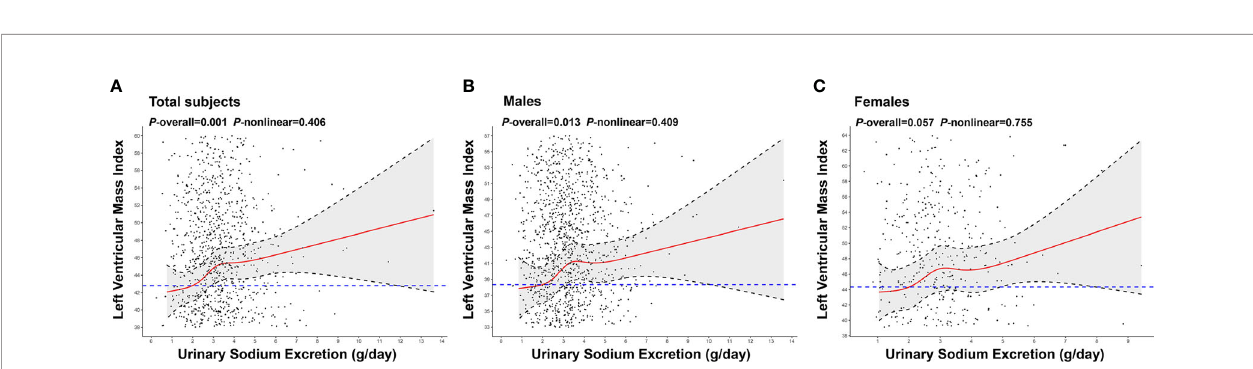
FIGURE 2 | Association of urinary sodium excretion with LVMI. The restricted cubic spline (RCS) regression was used to analyze the relationship of urinary sodium excretion(g/day) with left ventricular mass index (LVMI) after adjusting for age, gender, smoking, alcohol consumption, hypertension, use of RAS blocking agents, use of diuretics, history of hyperlipidemia, use of statin, HbA1c and use of antidiabetic medication in total individuals (A) , males (B) , females (C) . Urinary sodium excretion was coded using an RCS function with fi ve knots located at the 5th, 25th, 50th, 75th, 95th percentiles of the distribution of urinary sodium excretion. Y-axis represents the predicted value of LVMI. Individuals with 2g/day of urinary sodium excretion was the reference standard, indicated by the blue dashed lines. Black dots: “ observed ” data points. Black dashed lines: 95 percent con fi dence interval.